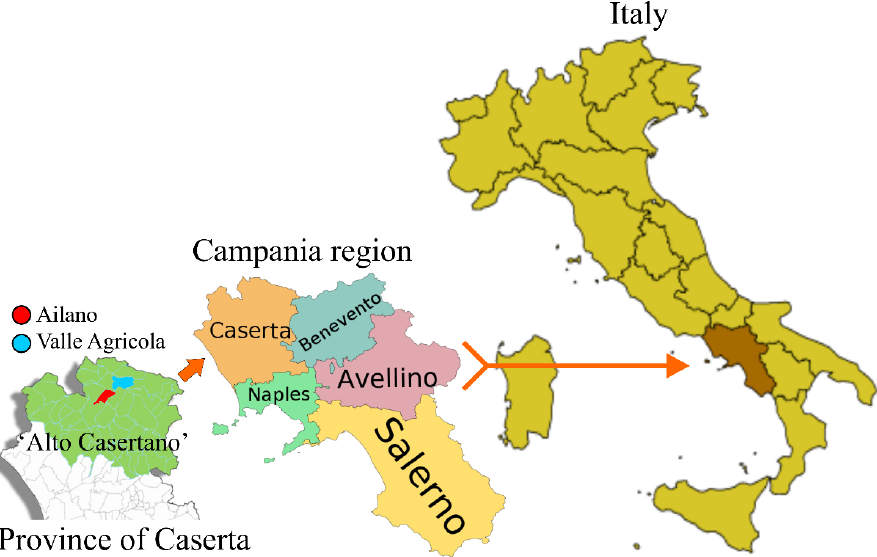
Figure 1. Localities (territory areas) of Ailano and Valle Agricola in which raw milks were sampled are highlighted in red and blue, respectively. are highlighted in red and blue,